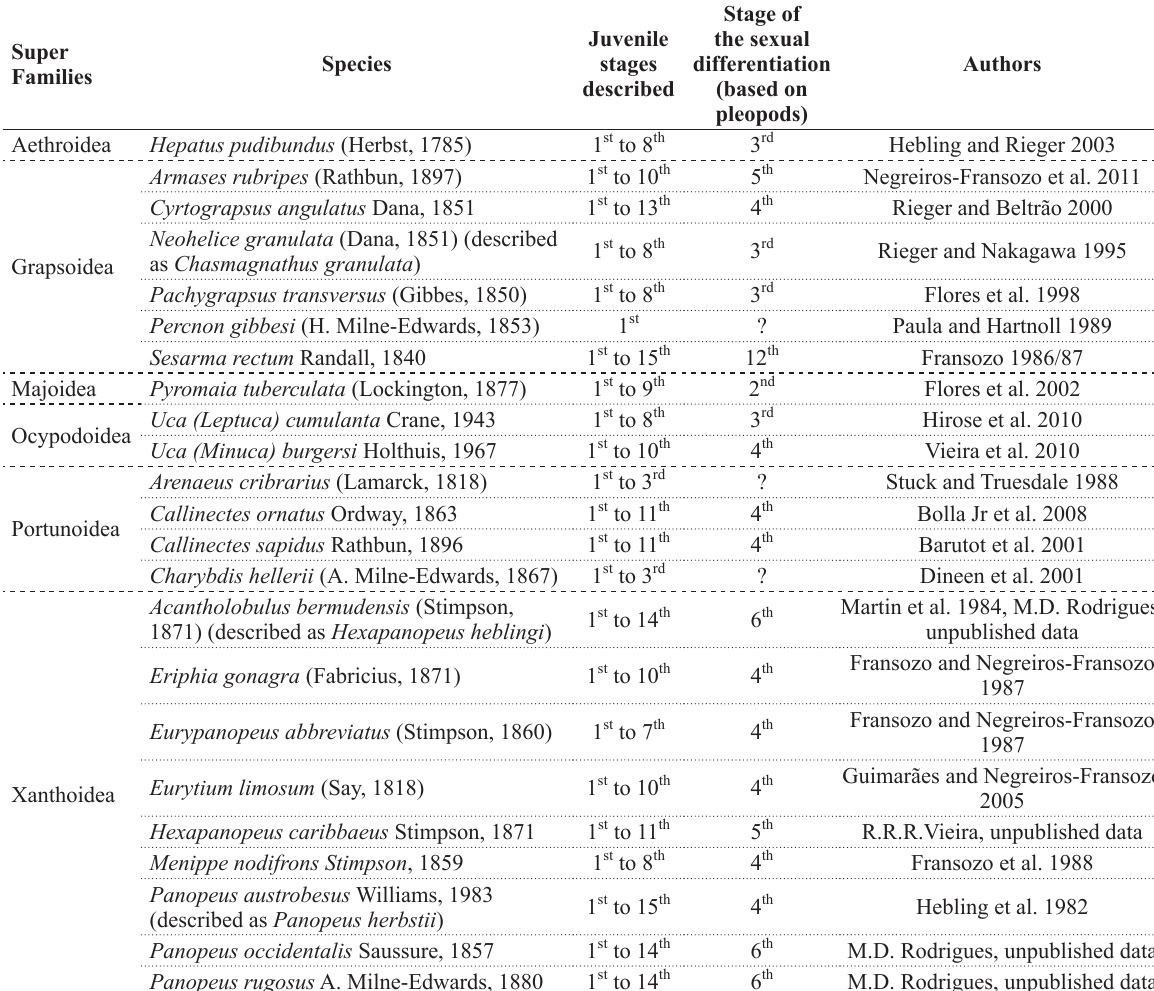
List of species with occurrence in the Brazilian coast, with some stages of the juvenile phase known to